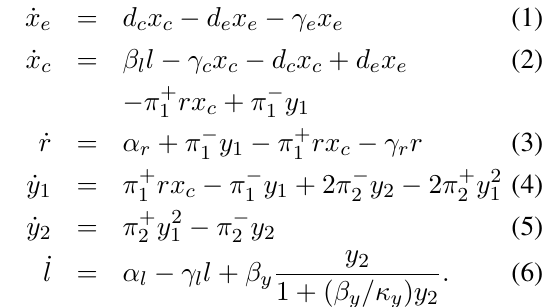
Fig. 1: Scheme of the lux -type Quorum sensing system with potential influences of regulators available experimentally derived quantitative data, we do not emphasize on real parameter values, which are realised in a specific species.